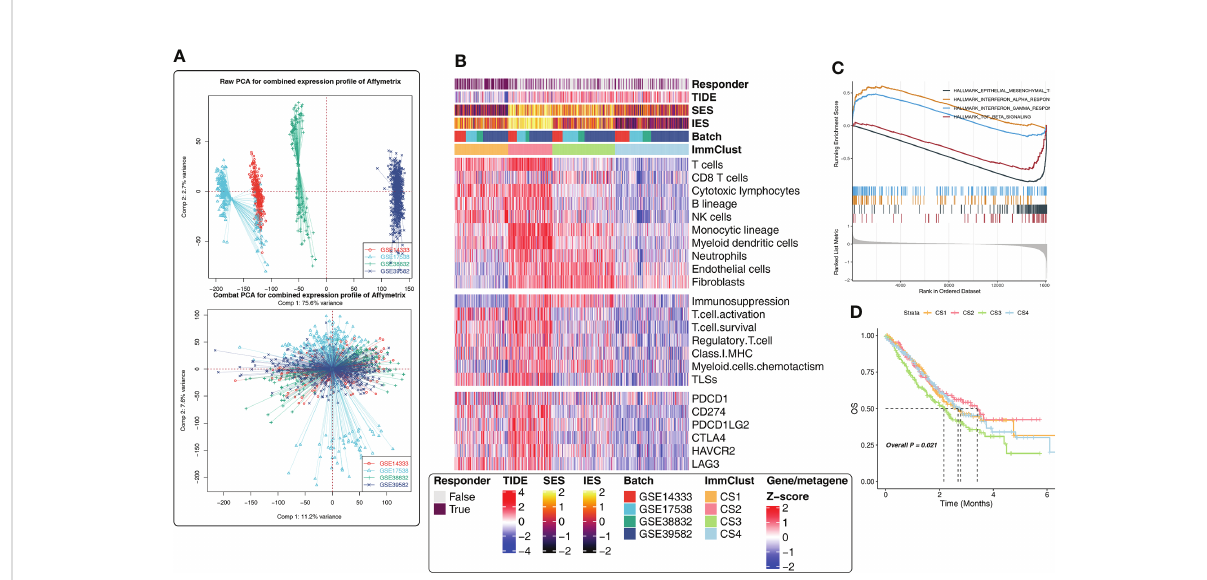
FIGURE 3 Immune-related cluster establishment for the Gene Expression Omnibus (GEO). (A) Batch effect removal of four external independent datasets using PCA analysis. (B) The heatmap showed the differences in the distribution of the four ImmClusts in clinicopathological features, TME compositions, functional orientation, immune checkpoints, and so on. (C) GSEA analysis comparing the differences of enrichment pathways between CS1 and the other ImmClusts. (D) K – M survival curves showed the differences of overall survival and recurrence rate among the four